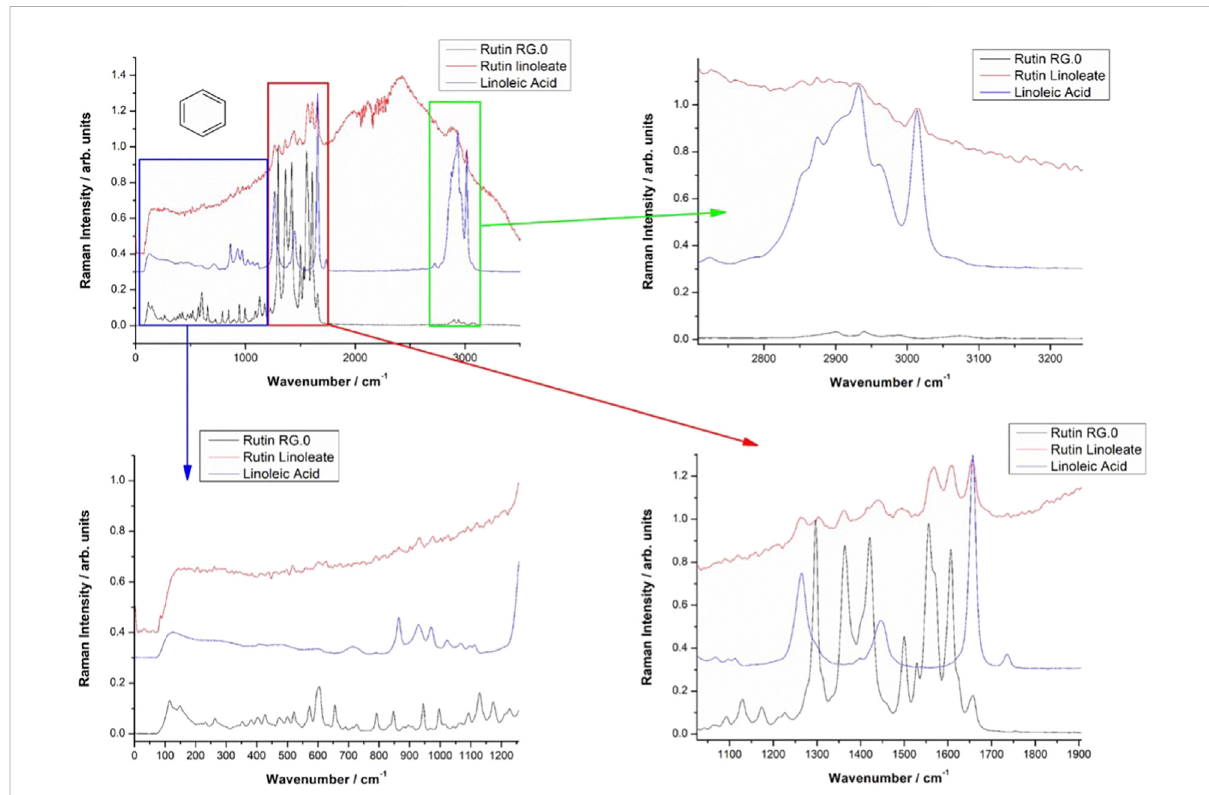
FIGURE 2 Comparative Raman spectra of Rutin (RUT), Linoleic acid (LA) and Rutin linoleate